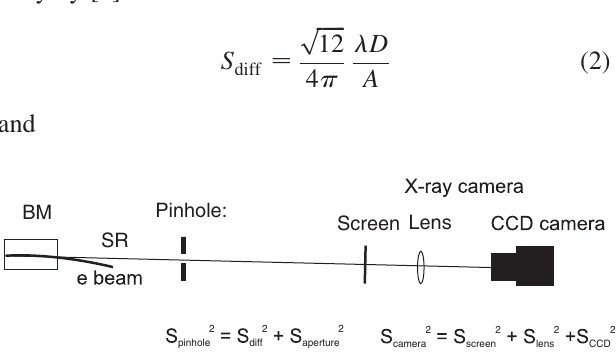
FIG. 1. Schematic of the pinhole camera system and the de- composition of the PSF. The relativistic electron beam (e beam) goes through a bending magnet (BM), emitting synchrotron radiation (SR). The electron beam is imaged by the pinhole onto the x-ray camera. For each element having a PSF Gaussian, the total PSF, (cid:1) 2 0 ¼ S 2 pinhole þ S 2 camera .